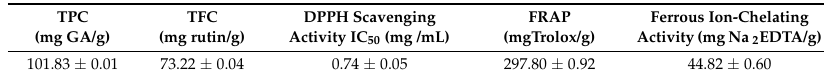
Table 2. The result of TPC, TFC and antioxidantactivities of SCPE in vitro.